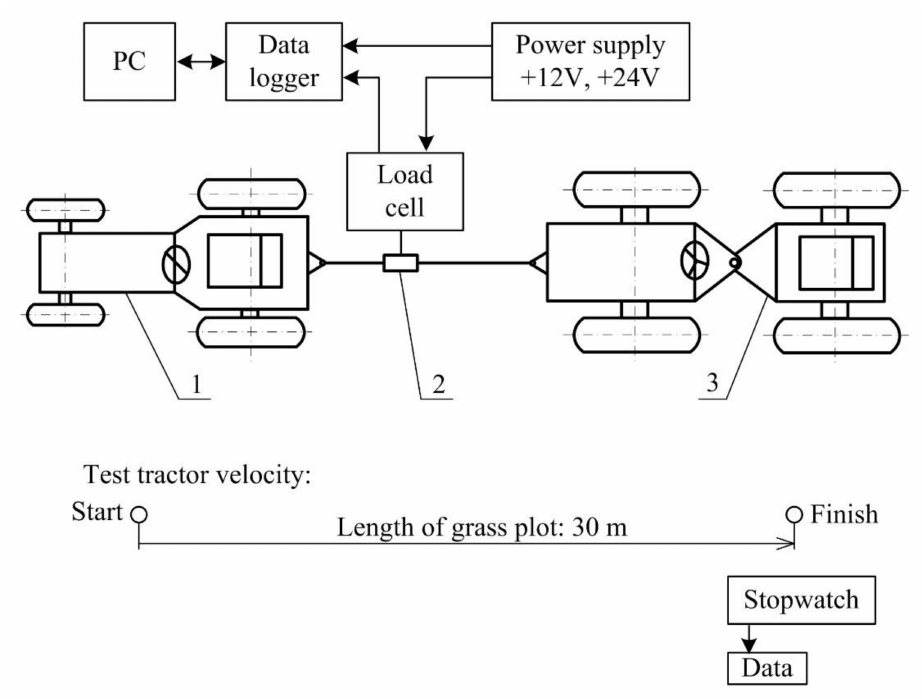
Figure 4. The system for measuring the drawbar pull of the tractor with different driving wheels: 1—test tractor; 2—load cell; 3—load